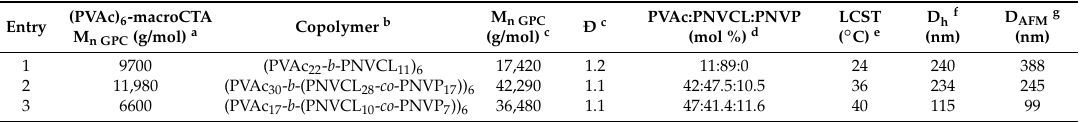
Table 4. Synthetic conditions and characteristics of the star [PVAc- b -(PNVCL- co -PNVP)] 6 block copolymers.